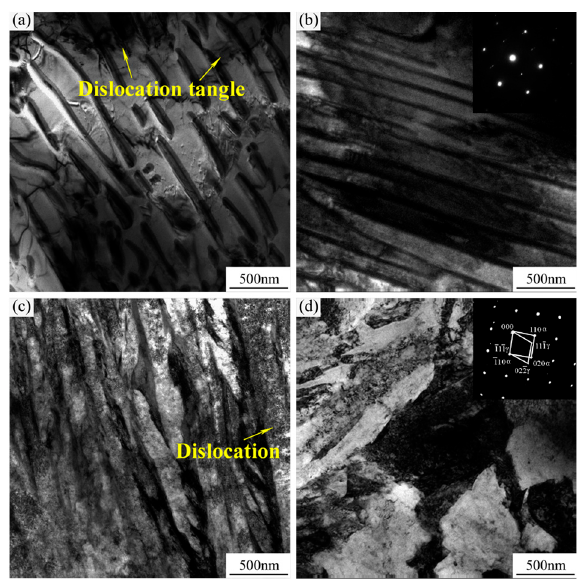
Figure 7. TEM images of the morphology and SAED of steel with an H/D value of 2.0 in the deformation process. ( a – b ) Before heat treatment and ( c – d ) after heat treatment.